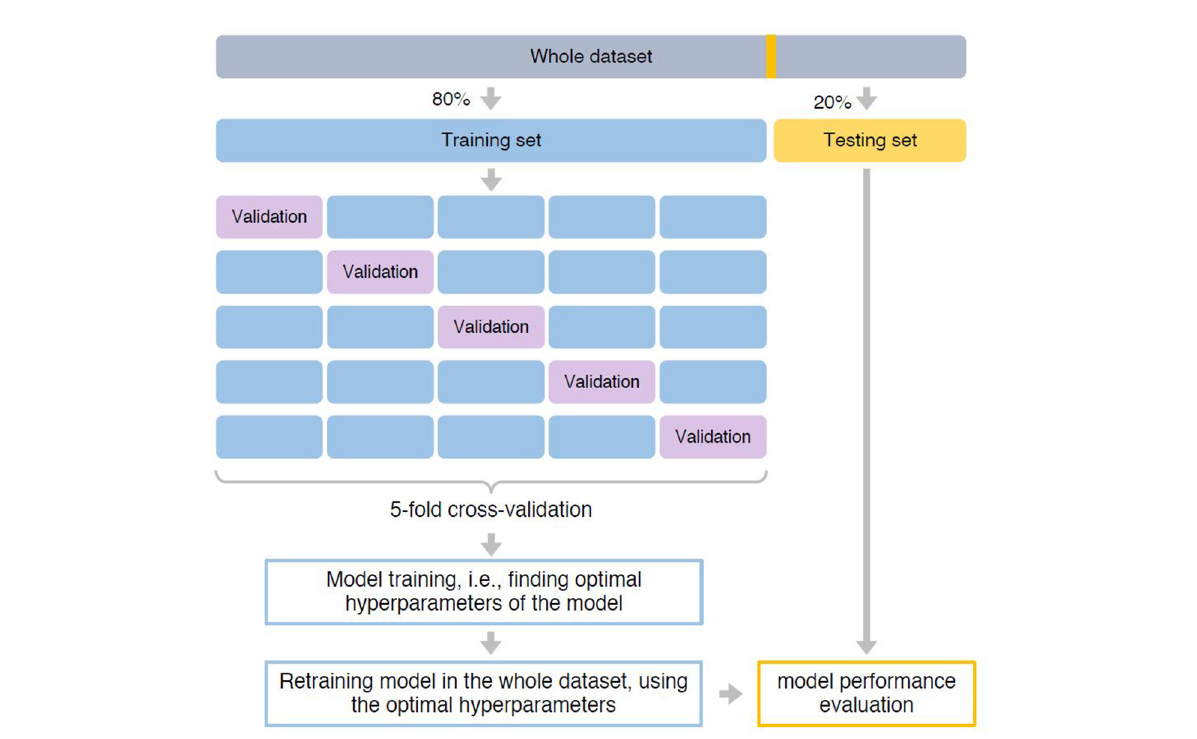
FIGURE1 Pipeline of building the predictive model. The whole dataset was first split into 80% training and 20% testing set. The training set was used for model training, i.e., finding optimal hyperparameters that can achieve best prediction performance. We used a five-fold cross-validation strategy. Specifically, the training set was split into five-folds with equal size. Each time, a fold was used as the hold-out validation set to calculate model performance, while the remaining four-folds were used to train model. The procedure was repeated five times to make sure each fold was used as the hold-out validation set once. After identified optimal hyperparameters based on which the model can achieve the best prediction performance, we retrained the predictive mode using the whole training set. Finally, model performance was evaluated in the testing set.